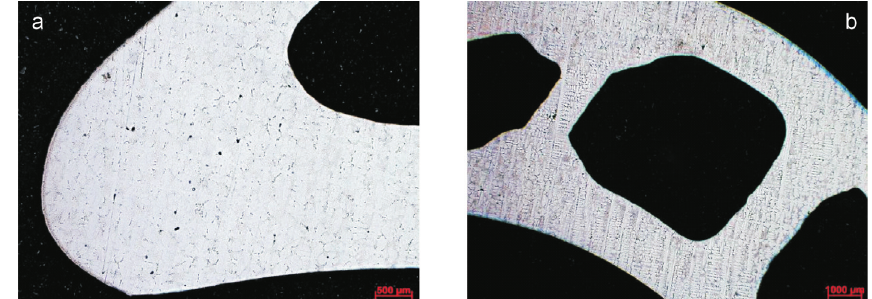
Fig. 4. The microstructure of blade No. 2: a) cross-section at the locking, dendritic structure, b) cross- section in the middle of the turbine blade leaf length, deviation from correct orientation of the crystal - lization direction,